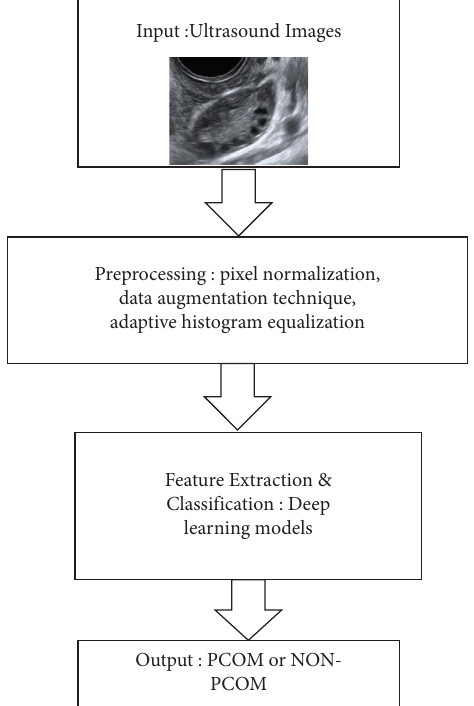
Figure 2: Diagram of the model for the PCOM